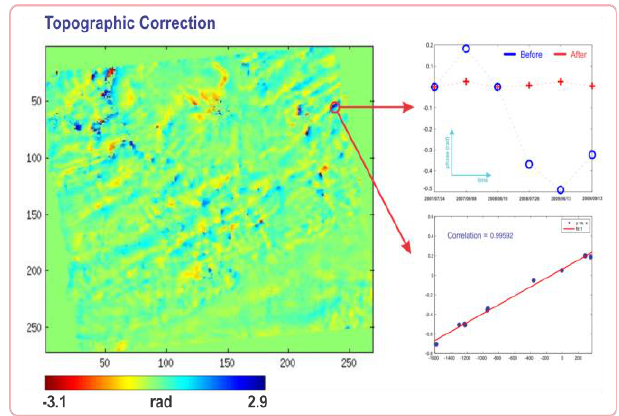
Figure 7: Left: Phase difference map. Right: Time series plot for a specific location before and after applying topographic correction. It is obvious DEM error in this location high correlation between phase and baseline implies on this matter.